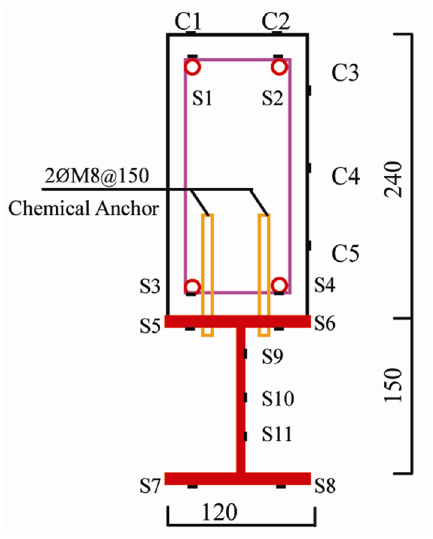
Fig. 4. Specimen section strain detail